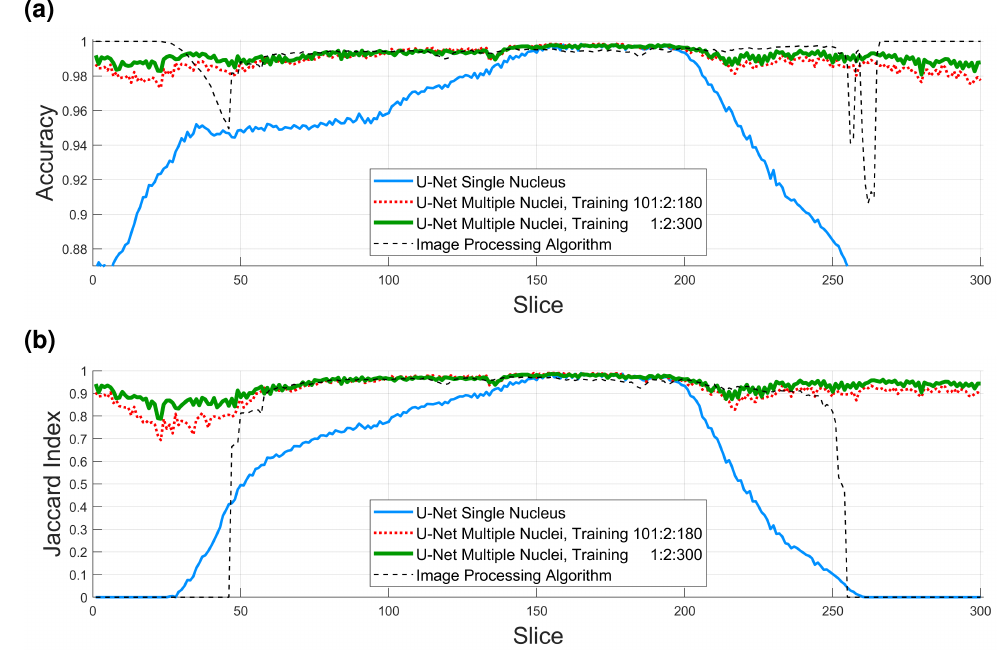
Figure 11. Numerical comparison of the four algorithms (U-Net single nucleus 36,000 patches, U- Net multiple nuclei 36,000 patches, U-Net multiple nuclei, 135,000 patches, image processing (IP) algorithm). ( a ) Accuracy. Average values for all slices (0.9346, 0.9895, 0.9922, and 0.9926), for slices 150:200 (0.9966, 0.9974, 0.9971, and 0.9945). ( b ) Jaccard similarity index (JI). Average values for all slices (0.5138, 0.9158, 0.9378, and 0.6436), for slices 150:200 (0.9712, 0.9778, 0.9760, and